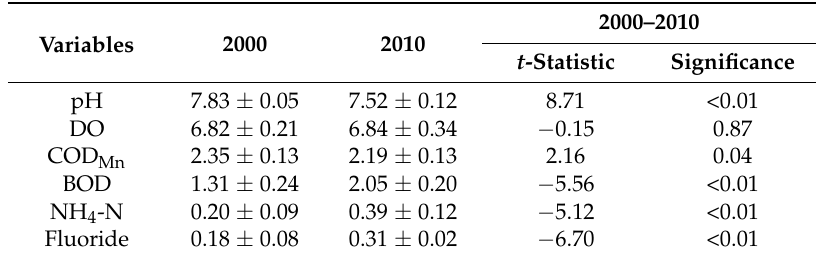
Table 1. Mean value and t -test results of water quality variables at the sample sites of Shunde district between 2000 and 2010.